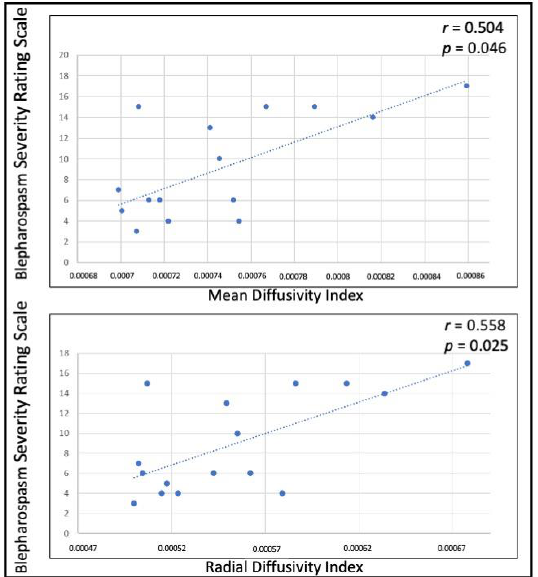
Figure 6. Correlation between diffusion tensor imaging metrics and blepharospasm severity scale is shown. Spearman ’s correlation test ( r and p are displayed).